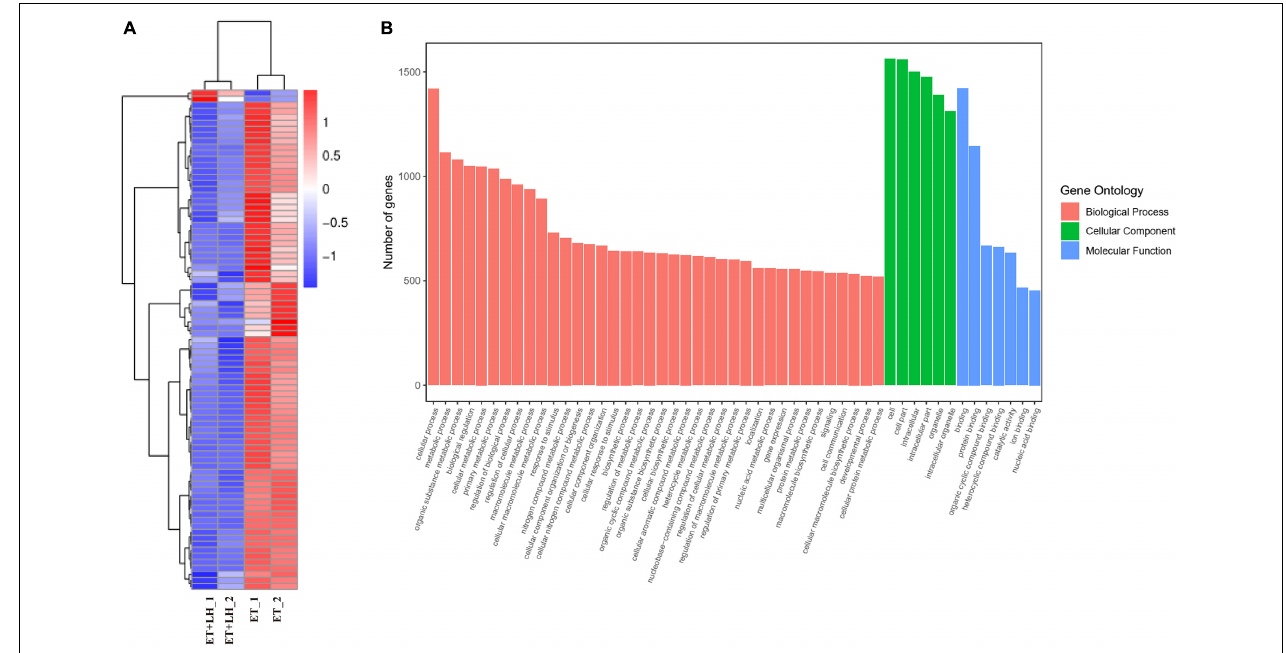
FIGURE 3 | Leonurine hydrochloride (LH) affects the genes expression of LO2 cells. (A) Transcriptomic changes of ethanol-treated LO2 cells exposed to LH (10 µ M) for 24 h. Cluster heatmap representing differentially expressed genes (DEGs) between the ET group and ET + LH group ( n = 2). The scaled expression value of each feature is plotted in red–blue color scale. Positive z-score (red) indicates a predicted up-regulated function and negative z-score (blue) is a down-regulated function. (B) Gene Ontology (GO) enrichment analysis. Different colors represent different GO: Biological processes (BP), Cellular component (CC) and Molecular functions